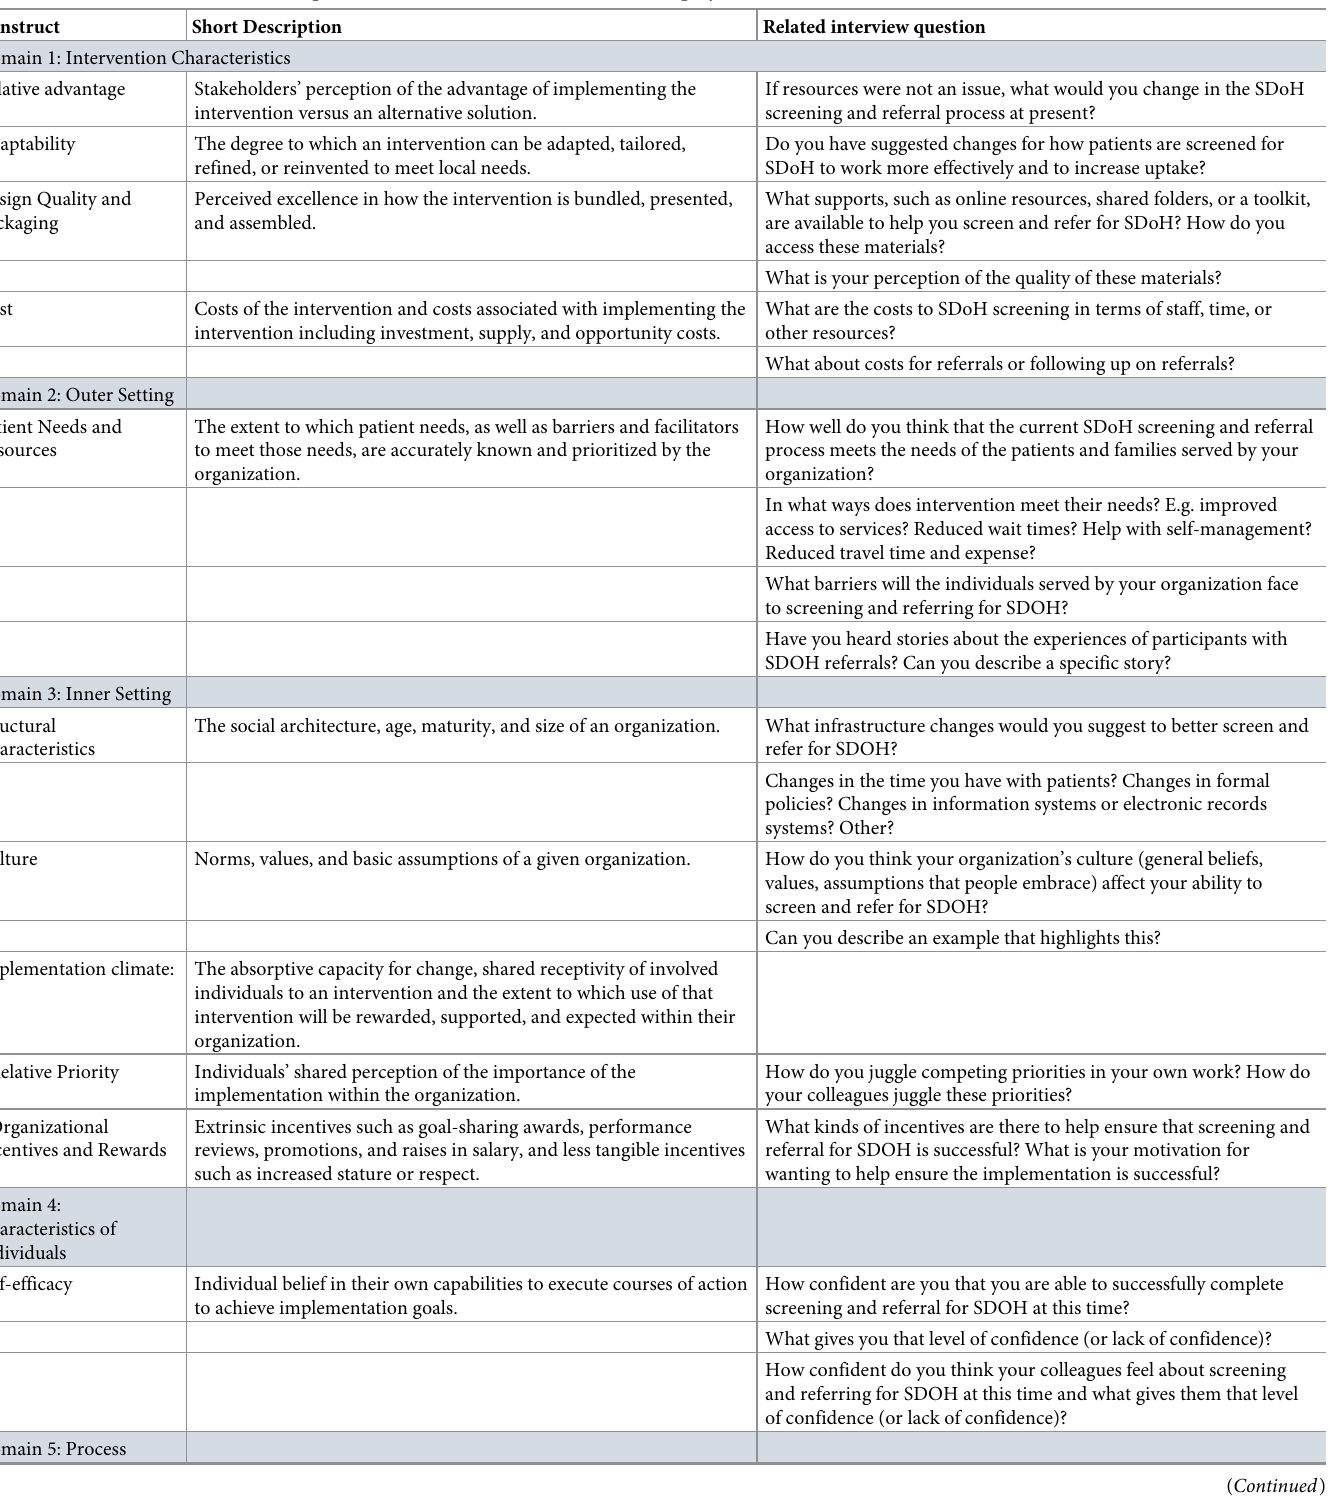
Table 1. Consolidated framework for implementation research constructs used in employee interviews